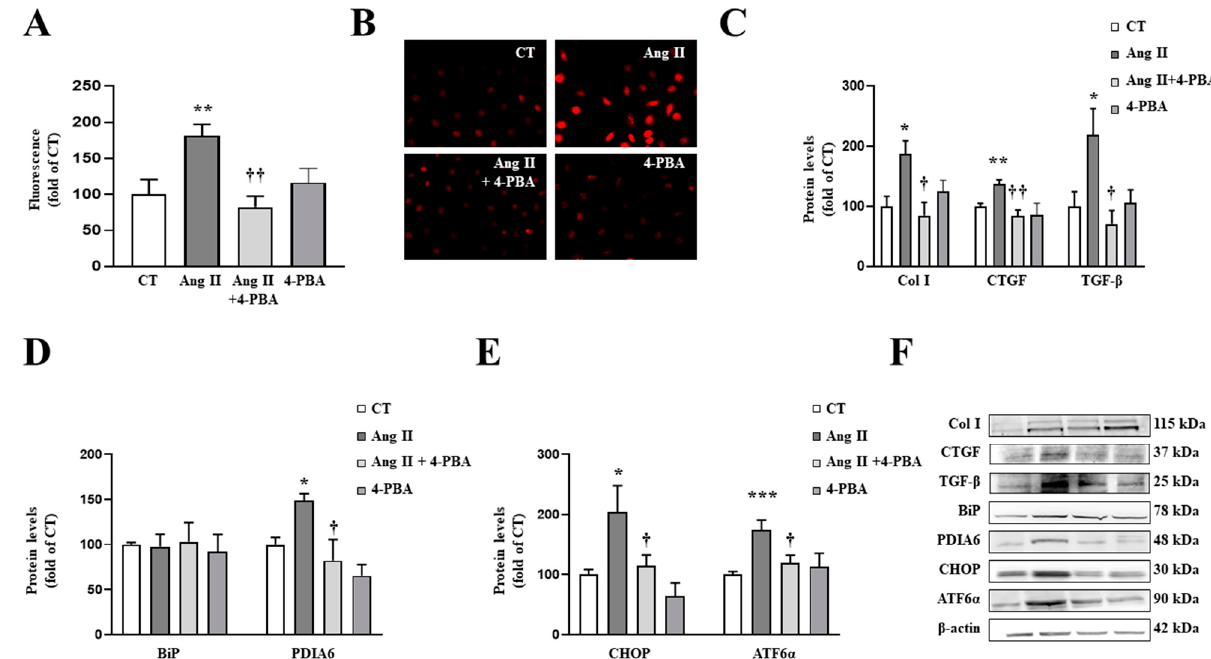
Figure 5. Endoplasmic reticulum stress mediates the prooxidant and profibrotic effects induced by angiotensin II (Ang II) in cardiac fibroblasts. ( A , B ) Effect of 4-phenylbutyrate acid (4-PBA; 4 µ M) on superoxide anion production. Quantification of cells labelled with the oxidative dye dihydroethidium ( A ) and representative microphotographs (magnification 40×) ( B ). Protein levels of ( C ) collagen type I (Col I), connective tissue growth factor (CTGF) and transforming growth factor- beta (TGF- β ); ( D ) immunoglobulin binding protein (BiP) and protein disulfide isomerase family A member 6 (PDIA6); ( E ) CCAAT-enhancer-binding protein homologous protein (CHOP) and activating transcription factor 6-alpha (ATF6 α ) in cardiac fibroblasts treated with Ang II (10 − 6 M) for 24 h in the presence or in the absence of 4-PBA. ( F ) Representative blots for protein expressions. Bars graphs represent the mean ± SEM of four to six assays normalized for β -actin. * p < 0.05, ** p < 0.01, *** p < 0.001 vs. control cells. † p < 0.05, †† p < 0.01 vs. Ang II-treated cardiac fibroblasts.